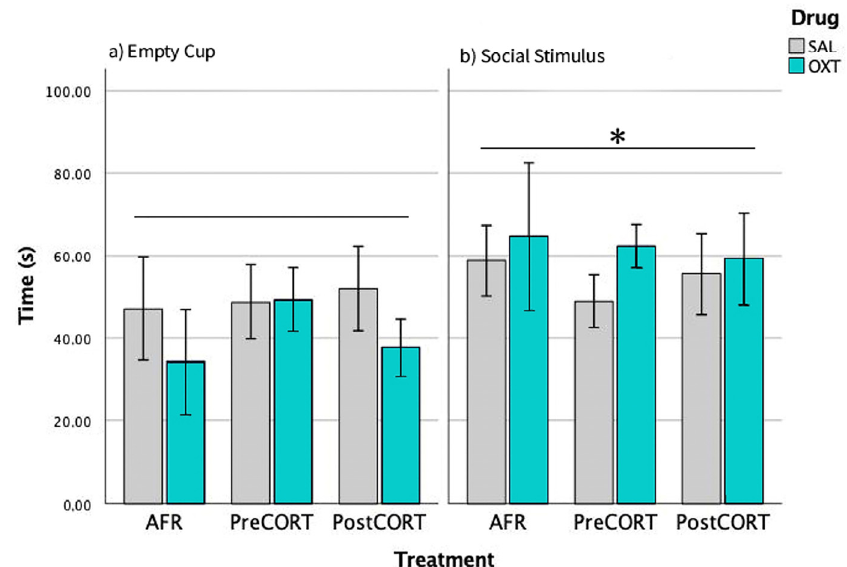
Figure 4. Sociability test, Episode 2. Comparison between time spent near the empty cup vs. cup containing the social stimulus. Subjects: AFR-SAL, AFR-OXT, PreCORT-SAL, PreCORT-OXT, PostCORT-SAL and PostCORT-OXT ( n = 8 for each group). During Episode 2, a general effect of the position was observed: all mice, regardless of the perinatal treatment and the drug administered before testing, spent increased time interacting with the social stimulus (* p < 0.05). Error bars indicate mean ± SEM.